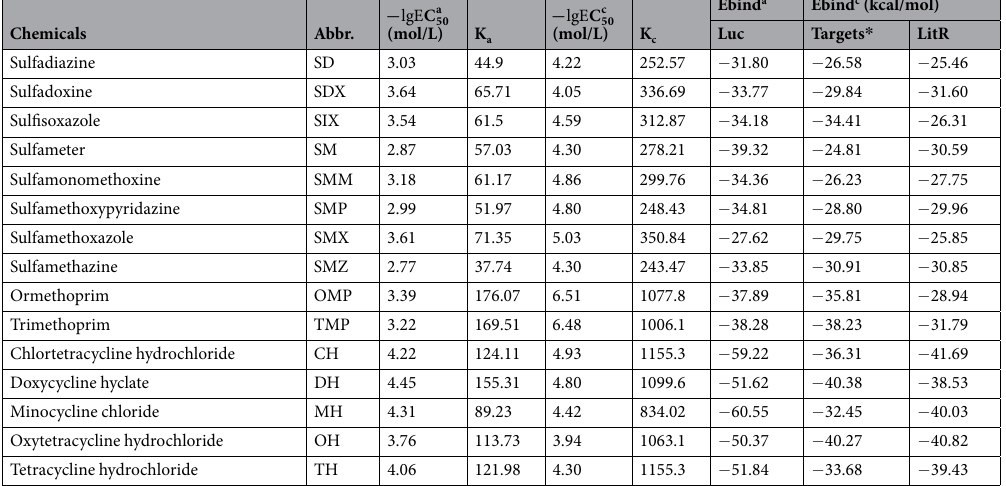
Table 1. Information on the test chemicals. a The target proteins for SAs, SAPs and TETs were DHPS, DHFR and 30 s subunit of ribosomes,